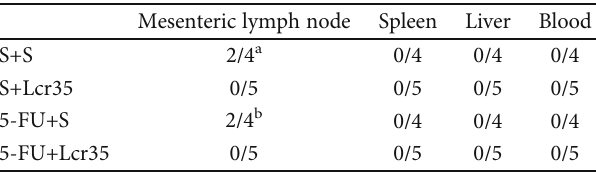
Plate colony culture (bacteria positive/mouse